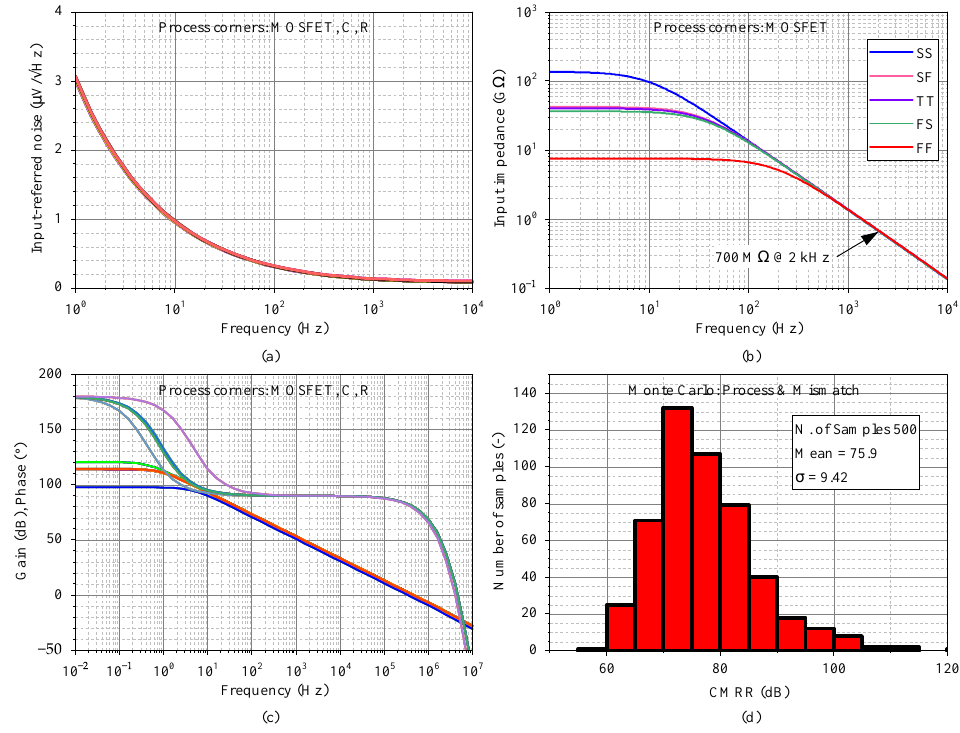
Figure 11. AC analysis of the circuit from Figure 10, including the corners of the MOSFETs, resistors, and capacitors where ( a ) input referred noise, ( b ) input impedance (only MOSFET corners), ( c ) gain including phase, and ( d ) histogram of CMRR are shown. Process corners of MOSFETs are listed in the order of NMOS-PMOS, where S is slow, T is typical, and F is the fast